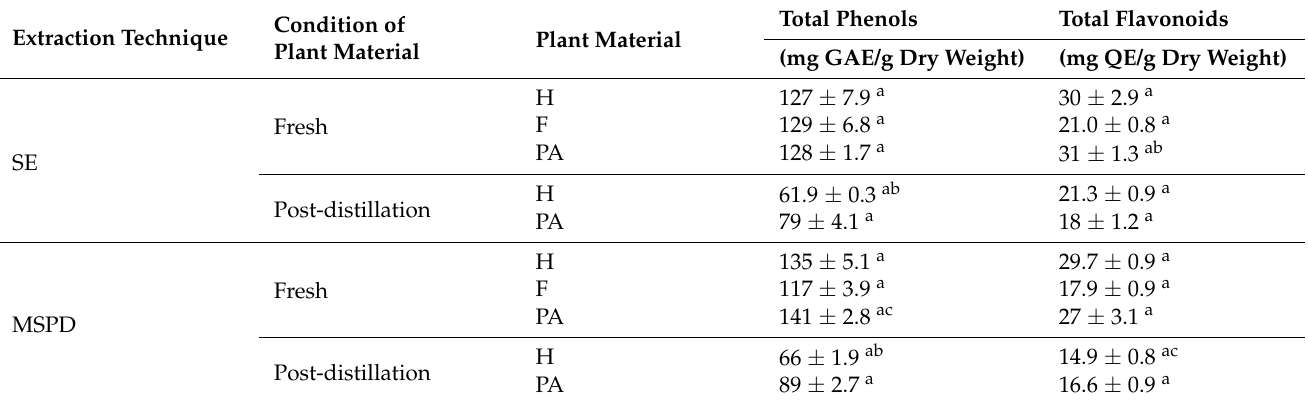
Table 2. Concentration of phytoconstituents present in the extracts obtained by different extraction techniques, according to plant material state and plant